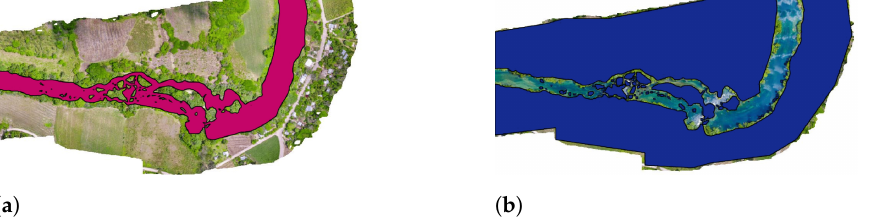
Figure 5. GIS views delimitation. ( a ) GIS view with the water surface polygon bounded with the orthophoto. ( b ) GIS view with bounded terrain surface polygon with the